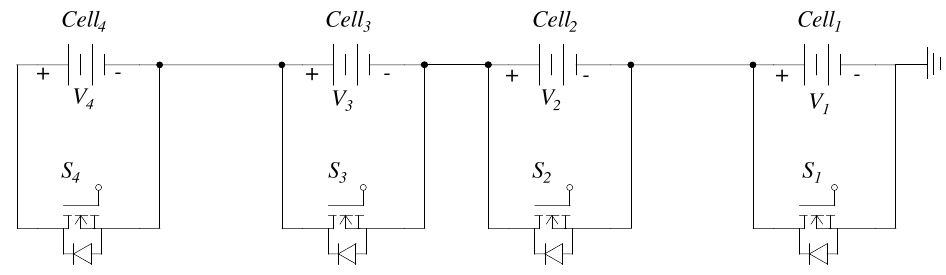
Figure 6. Shunt switch equalizer